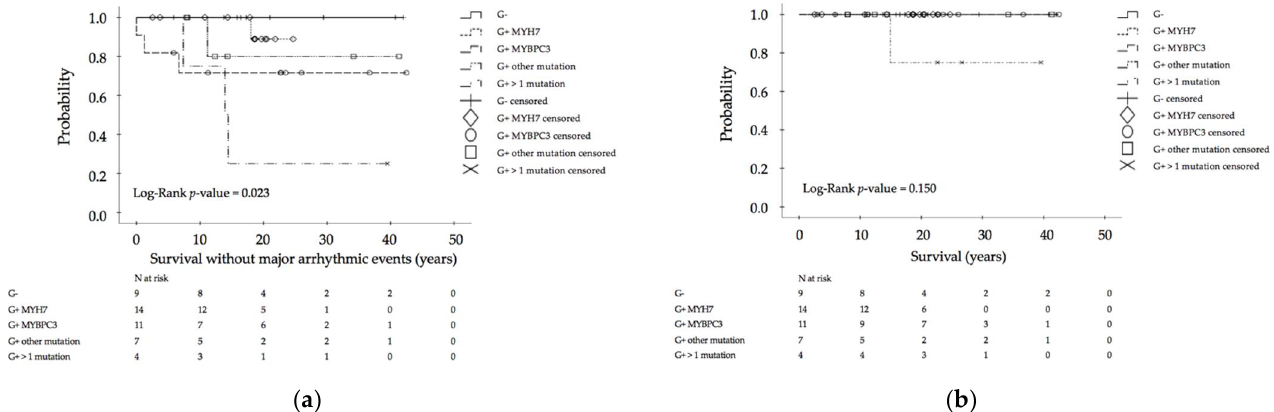
Figure 3. Morbidity and clinical outcome Part I: ( a ) Kaplan–Meier calculation of survival without major arrhythmic events (MAEs) (reanimation or appropriate implantable cardioverter defibrillator discharge or sudden cardiac death) in hypertrophic cardiomyopathy (HCM) patients, depending on different mutations; ( b ) Kaplan–Meier calculation of overall survival; SCD: sudden cardiac death, G − : genotype-negative patients, G+ MYH7: genotype-positive patients with β -myosin heavy chain single-mutation, G+ MYBPC3: genotype-positive patients with myosin binding protein C single-mutation, G+ others: genotype-positive patients with cardiac troponin T2, cardiac troponin I3, α tropomyosin and myosin light chain 2 single-mutations, G+ multiple mutation: genotype-positive patients with compound mutations.